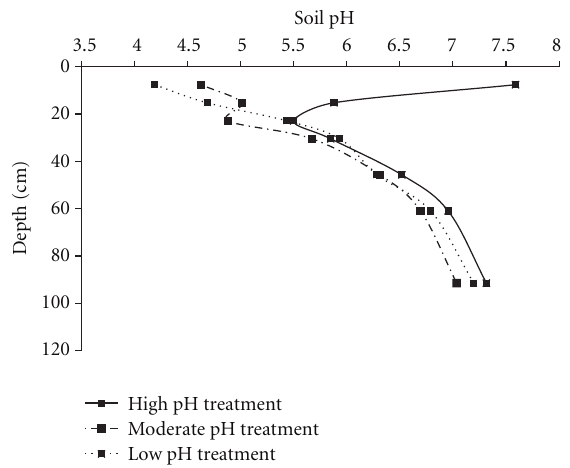
Figure 2: Postharvest soil profile pH at Lahoma, OK, USA for target pH treatments of 4.0, 6.0, and 7.0